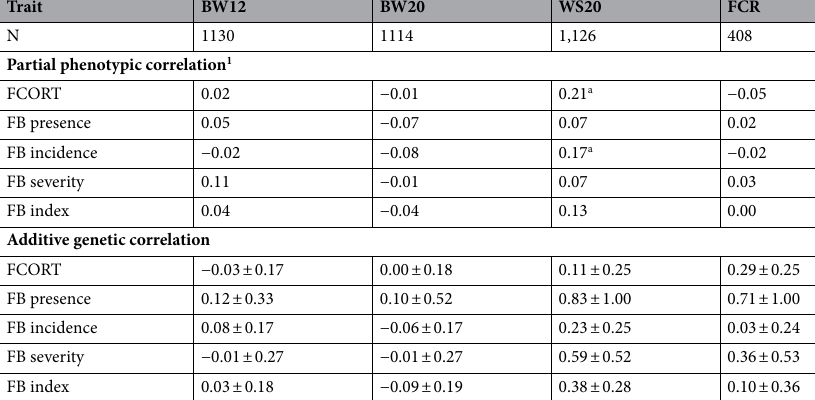
traits (r p = −0.11 to −0.14). Genetic correlations between FCORT and the fault bar traits varied from -0.07 to 0.39 with large standard errors. The other fault bar traits showed moderate to high partial phenotypic and genetic correlations among them. The phenotypic correlations ranged from 0.48 to 0.87 and the genetic correlations ranged from 0.68 to 1.00 (SE range: 0.17–0.63). Genetic and partial phenotypic correlations of feather traits and growth and efficiency traits are presented in Table 2. In general, both FCORT and fault bar traits had low and insignificant phenotypic correlations with body weight, walking score and feed conversion ratio, except for walking score with FCORT (0.21) and fault bar incidence (0.17). Genetic correlations among FCORT and fault bar traits with body weight, walking score and feed conversion ratio ranged from zero to 0.83, but the SE were generally high. When considering specific carcass traits, FCORT showed low-moderate partial phenotypic correlations with the different cut weights and yield (Table 3). There were significant partial phenotypic correlations with total breast weight (−0.16), breast meat yield (−0.23), fillet weight (−0.18), and drum weight (0.17). None of the other fault bar traits showed significant partial phenotypic correlations with the carcass traits. Genetic correlation estimates between FCORT and fault bar traits with carcass traits fluctuated from low to high; however, SE were also high for most estimates. Nevertheless, FCORT showed a moderate genetic correlation with total breast weight (−0.34 ± 0.21), breast meat yield (−0.45 ± 0.23), and fillet weight (−0.33 ± 0.24). Fault bar incidence and fault bar index were genetically correlated with total breast weight (fault bar incidence: −0.23 ± 0.18; fault bar index: (−0.20 ± 0.18), and breast meat yield (fault bar incidence only: −0.26 ± 0.21). FCORT and the fault bar traits demonstrated low partial phenotypic correlations with the meat quality traits (Table 4), and, apart from some correlations with drip loss and cooking loss, none of these correlations were significant. Genetic correlation estimates between FCORT and the meat quality traits were low to moderate, suggesting a moderate correlation between FCORT and ultimate pH (0.32 ± 0.24) as well as fault bar index and a* (−0.31 ± 0.24). However, it should be acknowledged that the standard errors of all estimates were high.